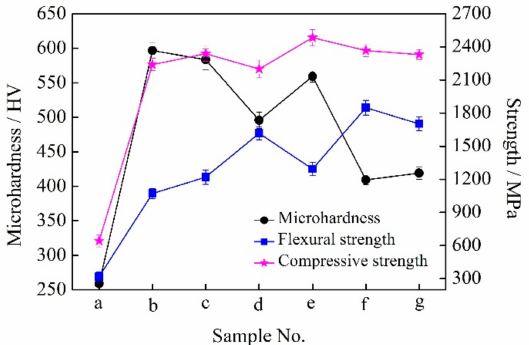
Figure 7. Microhardness, flexural strength and compressive strength of W-6Ni-4Co alloys by the di ff erent sintering processes: ( a ) 1200 ◦ C, 30 min; ( b ) 1450 ◦ C, 5 min; ( c ) 1450 ◦ C, 20 min; ( d ) 1450 ◦ C, 60 min; ( e ) 1500 ◦ C, 5 min; ( f ) 1500 ◦ C, 20 min; ( g ) 1500 ◦ C, 60